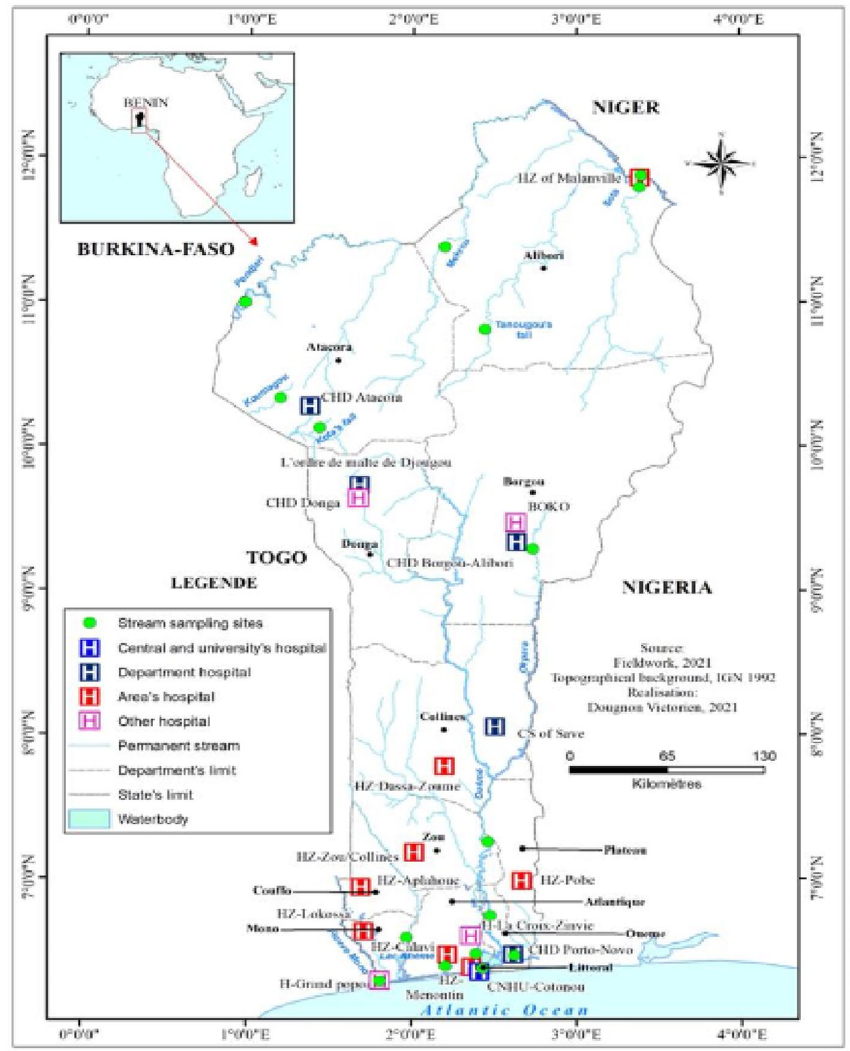
Fig. 1 Hospital effluents collec- tion